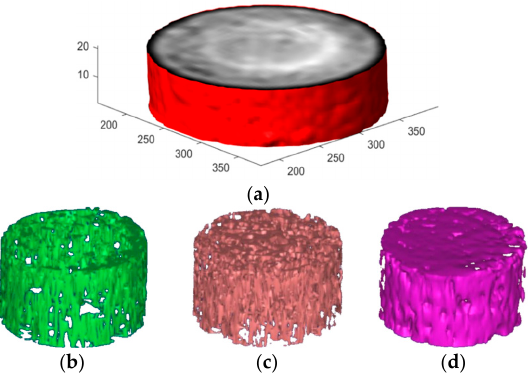
Figure 6. 3D reconstruction and threshold segmentation. ( a ) 3D reconstruction effect, ( b ) Pore, ( c ) Asphalt mortar, ( d ) Aggregate.